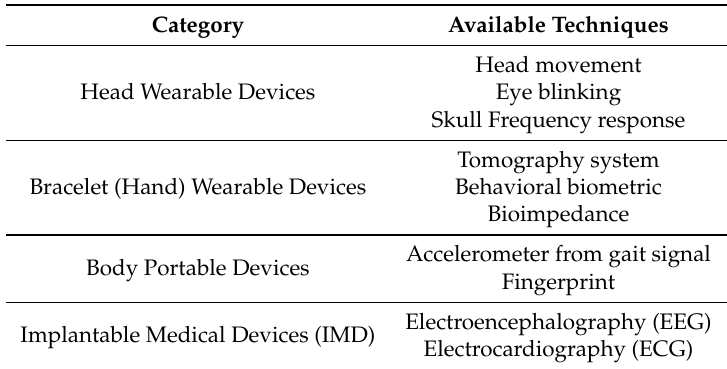
Table 3. WBAN authentication categories based on